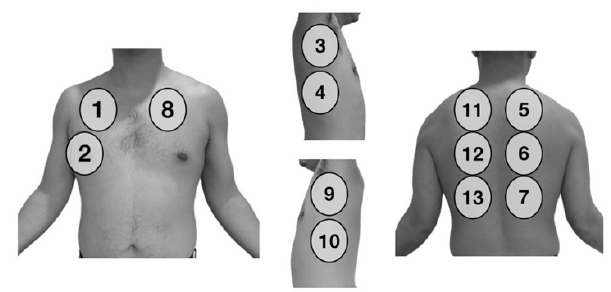
Figure 1. The 13 zones of the chest scanned in each patient.